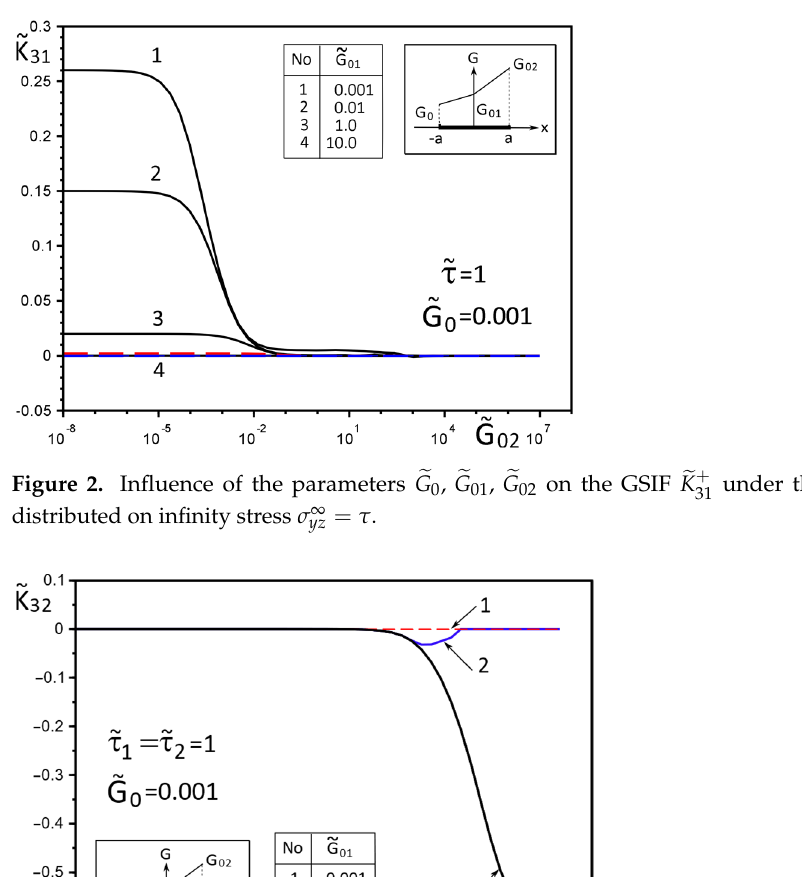
Figure 3. Influence of the parameters (cid:101) G 0 , (cid:101) G 01 , (cid:101) G 02 on the GSIF (cid:101) K + distributed on infinity stress σ ∞